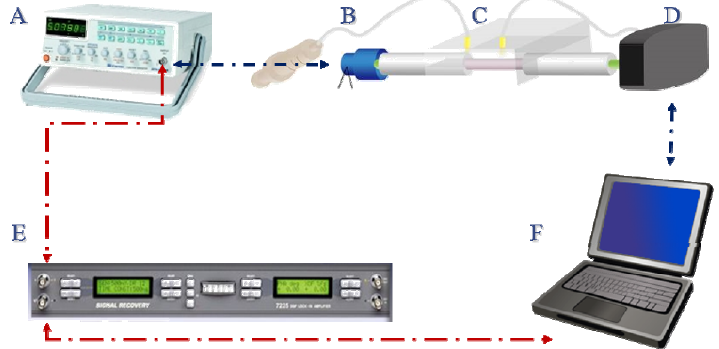
Figure 1. Schematic representation (not to scale) of the experimental setup used for the fiber optic particle plasmon resonance (FOPPR) sensing system. The system consists of: (A) function generator; (B) LED; (C) sensor chip; (D) photoreceiver; (E) lock-in amplifier; (F) computer.